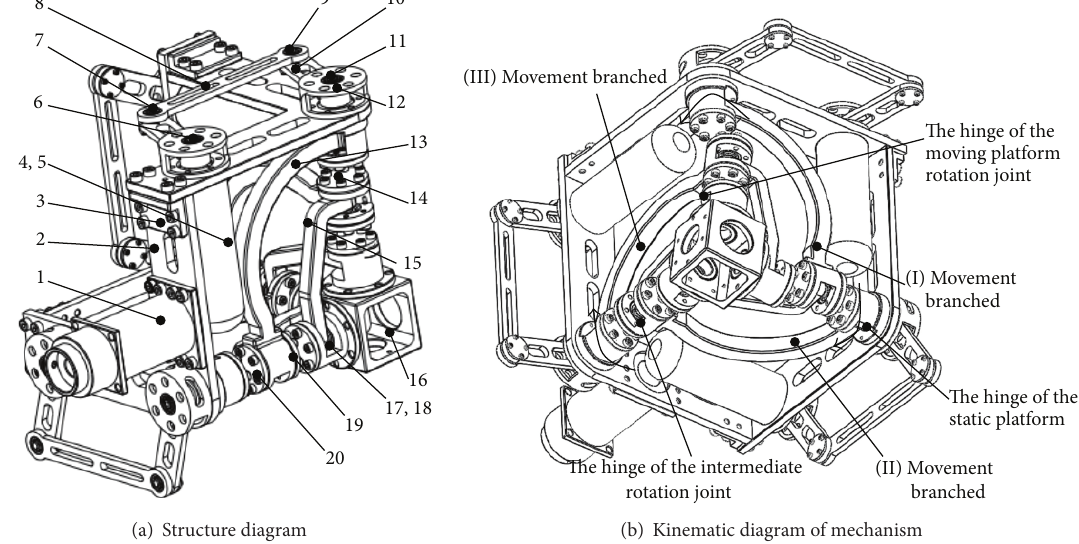
Figure 1: A novel biomimetic robotics hip joint virtual prototype. 1: trunk stent, 2: frame, 3: connectors A, 4: motor, 5: coupling, 6, 7, 9, 11, 14, and 17: revolute joint, 8: long rod, 10: short-bar, 12: connectors B, 13: frame connecting rod, 5: connecting rod, 16: moving platform, 18: rotation bracket, 19: end cover, and 20: screw.